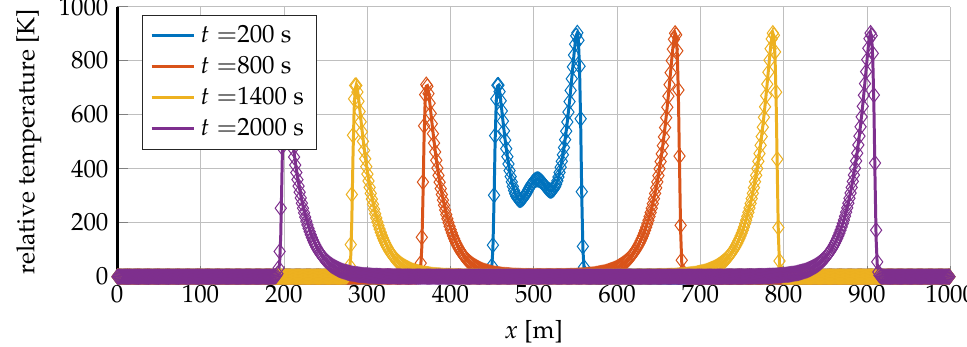
Figure 13. Temperature snapshots of the FOM (solid lines) and sPOD-sDEIM ROM approximation (diamonds) with wind speed v = 0.02 ms − 1 for β = 565.50